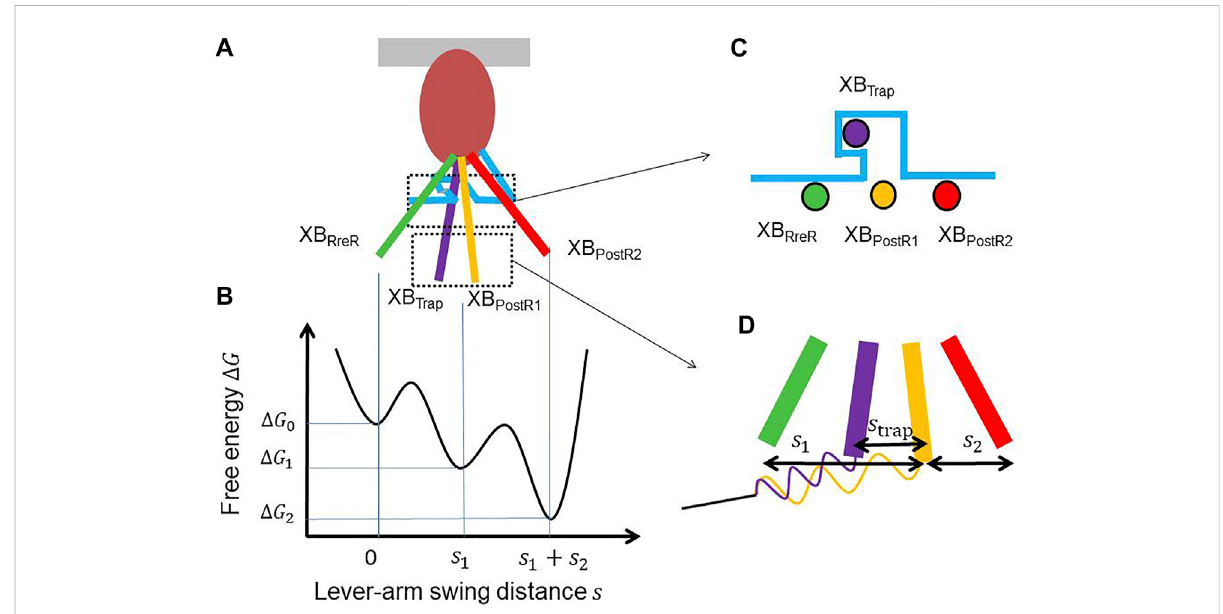
FIGURE 2 (A) Lever arm rotations at the four attached states with a hook (light blue) that traps the XB Trap state. (B) The free energy pro fi le that drives the power strokes. (C) A cross-sectional view of the lever arm positions of the four attached states. (D) Magni fi cation of the lever arm rotations with the spring of the myosin rod. The distortion of the myosin rod decreases by s trap during trapping, while it increases by s trap while